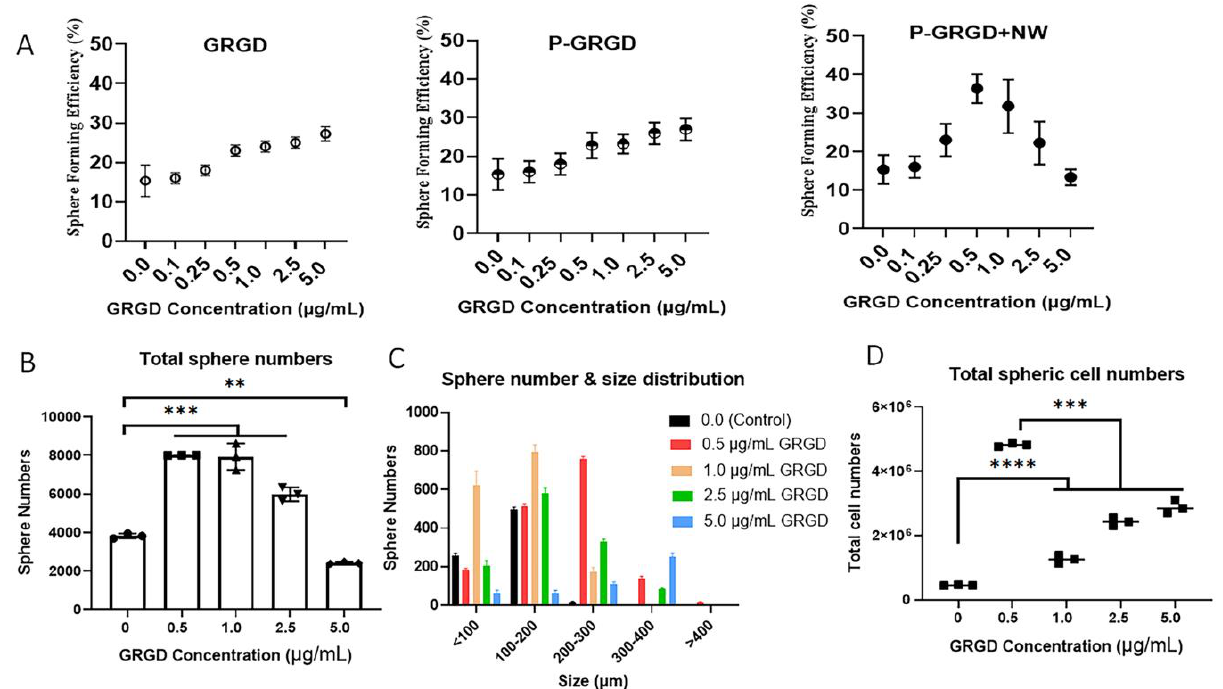
Figure 2. Effect of RGD dose on sphere formation and spheric cell growth. ( A ) SFE after treatment with free GRGD, PNIPAM-GRGD (P-GRGD) at the same doses of RGD as free GRGD, and P- GRGD+NW (5.0 µg/mL nano-worm). ( B ) total sphere number after cell culture for P-GRGD+NW system. ( C ) sphere size distribution at culture using the P-GRGD+NW system. ( D ) total spherical cell numbers in the spheres using the P-GRGD+NW system. Notes: **: P < 0.01; ***: P < 0.001; ****: P < 0.0001 ( n = 3). The amount of NW used in these experiments was 5.0 µ g/mL.